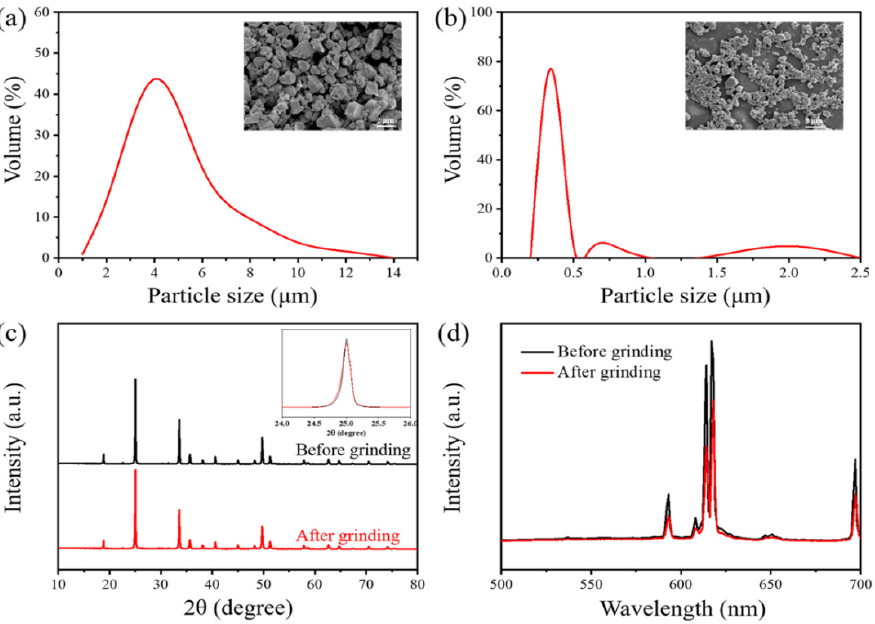
Figure 6. ( a ) The initial particle size distribution of Eu04. ( b ) Particle size distribution of Eu04 after grinding. ( c ) XRD spectra before and after grinding. ( d ) Emission spectrum before and after grinding.